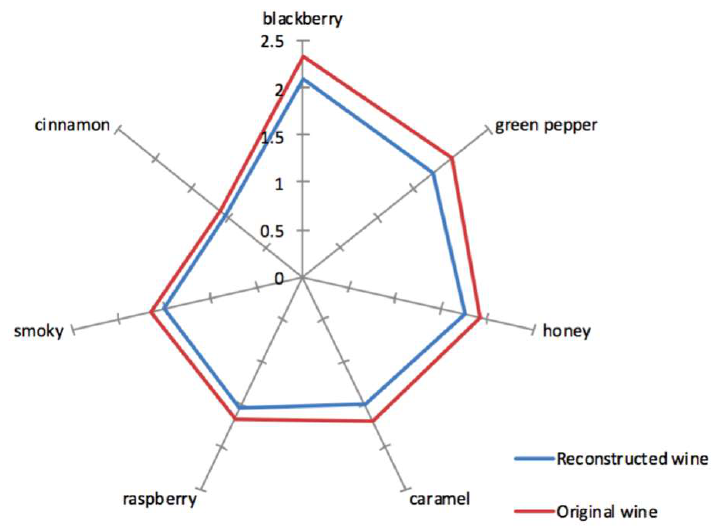
Figure 2. Comparison of the main aroma attribute between Marselan wine and its recombinate wine.